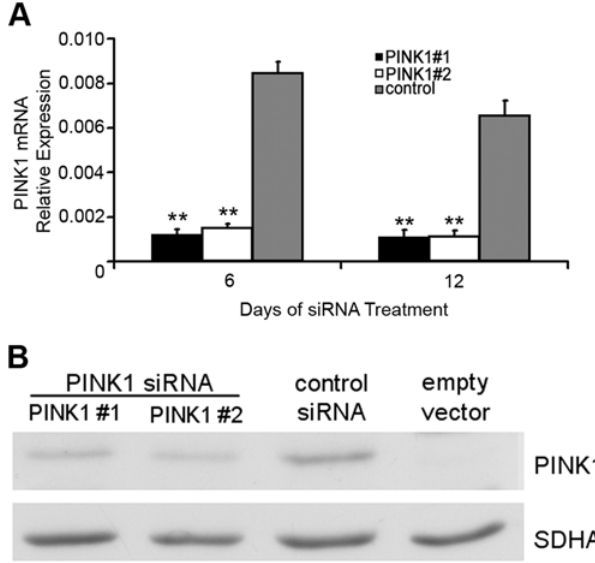
Figure 1. Silencing of PINK1 mRNA and protein expression in SH-SY5Y cells. A, SH-SY5Y cells were transfected with PINK1 siRNA (PINK1 # 1 or PINK1 # 2) or scrambled control siRNA for 6 or 12 days and PINK1 mRNA levels measured by reverse transciption and quantitative real-time PCR. Relative expression was determined against GAPDH mRNA levels and data were expressed as mean 6 s.e.m. ( n =4). ** P , 0.01 vs. scrambled control siRNA. B, SH-SY5Y cells over-expressing recom- binant PINK1 protein were transfected with either PINK1 siRNA (PINK1 # 1 or PINK1 # 2) or scrambled control siRNA for 40 hours. The expression of full-length recombinant PINK1 protein was determined in cell lysates by western blotting. No band was detected in SH-SY5Y transfected with empty vector. Protein loading was verified with antibody against succinate dehydrogenase subunit SDHA. (Figure 1A) does result in decreased endogenous protein expression.